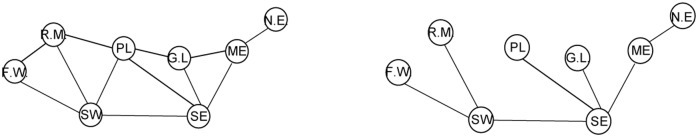
The graph representation (on the left) and the dense spanning tree (on the right).